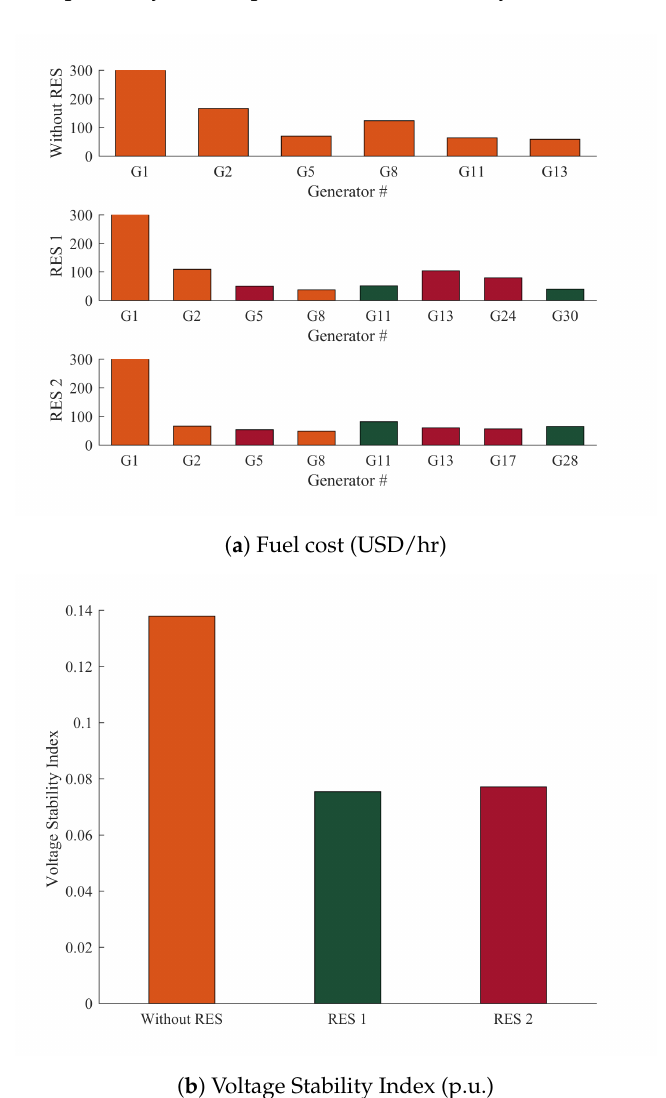
Figure 12. Fuel cost and Voltage Stability Index for case 7 for IEEE 30-bus system, IEEE 30-bus Modified (1) and IEEE 30-bus Modified